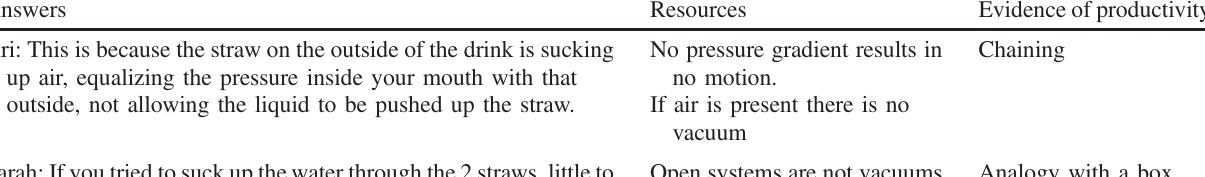
TABLE X. Student answers to the double straw question.